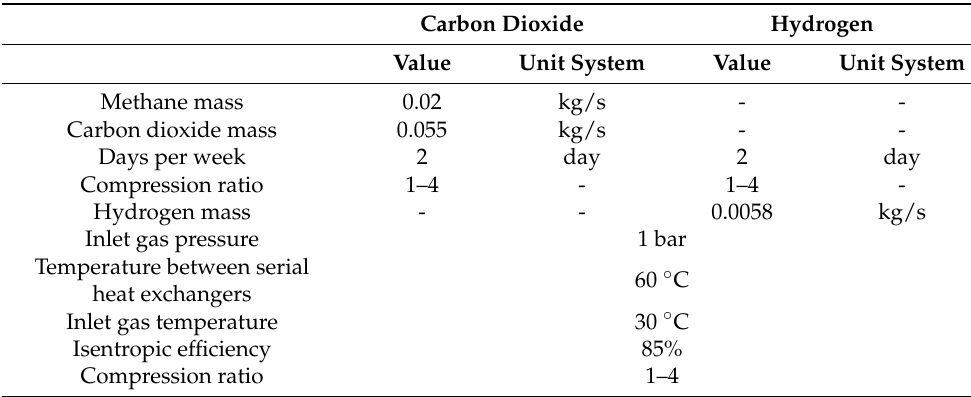
Table 7. Boundary conditions for the optimization